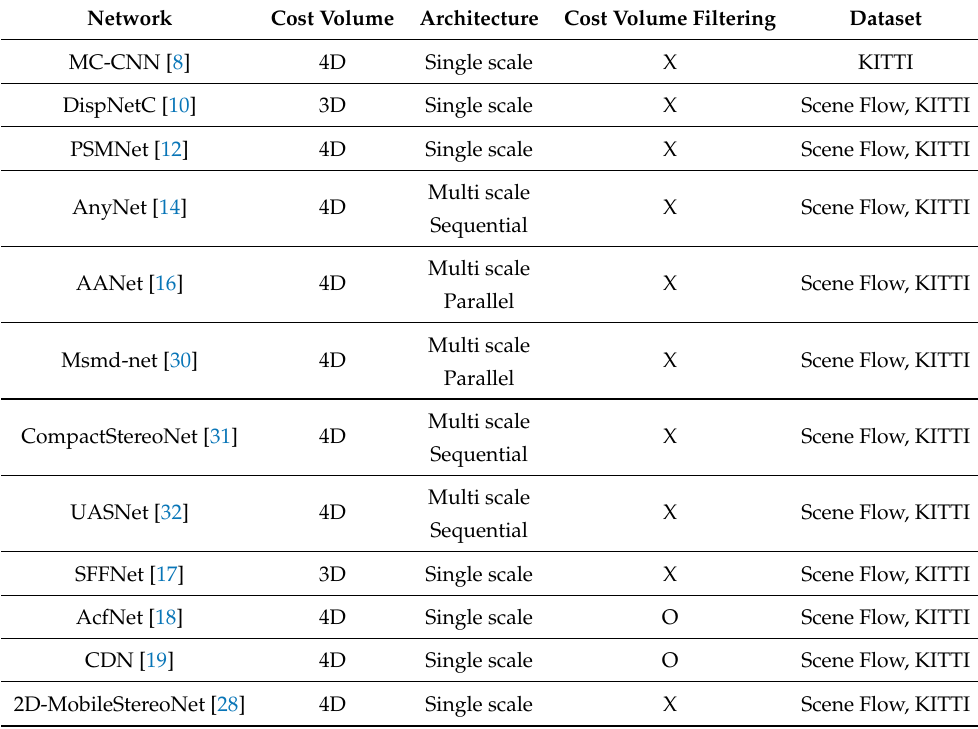
Table 1. A comparison of relevant stereo-matching